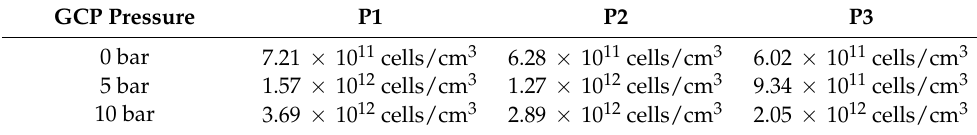
Figure 7. The effect of different GCP pressures on foaming morphology. Table 7. Averaged cell density at different GCP pressures (SCF 0.7%wt, GCP holding time 50 s).